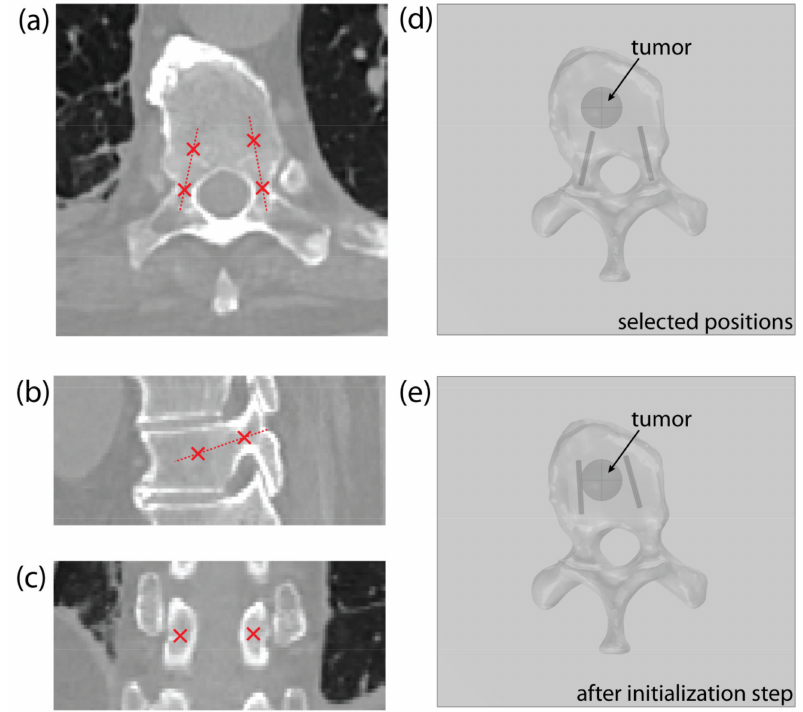
Figure 4. An example of point selection shown on the ( a ) axial, ( b ) sagittal, and ( c ) coronal CT slice of a thoracic vertebra. ( d ) An example of the model’s geometry in COMSOL Multiphysics, showing a thoracic vertebra and a spherical tumor, with starting electrode positions, obtained from the selected points. ( e ) Corrected electrode positions after algorithm initialization